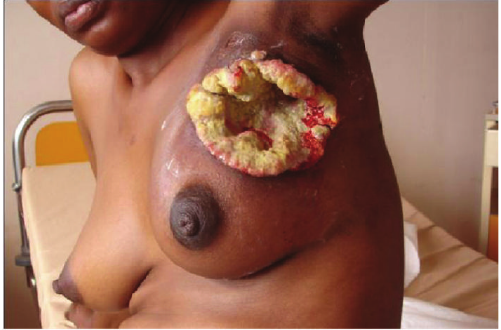
Figure 4: Picture of a 35-year-old lady with advanced left breast